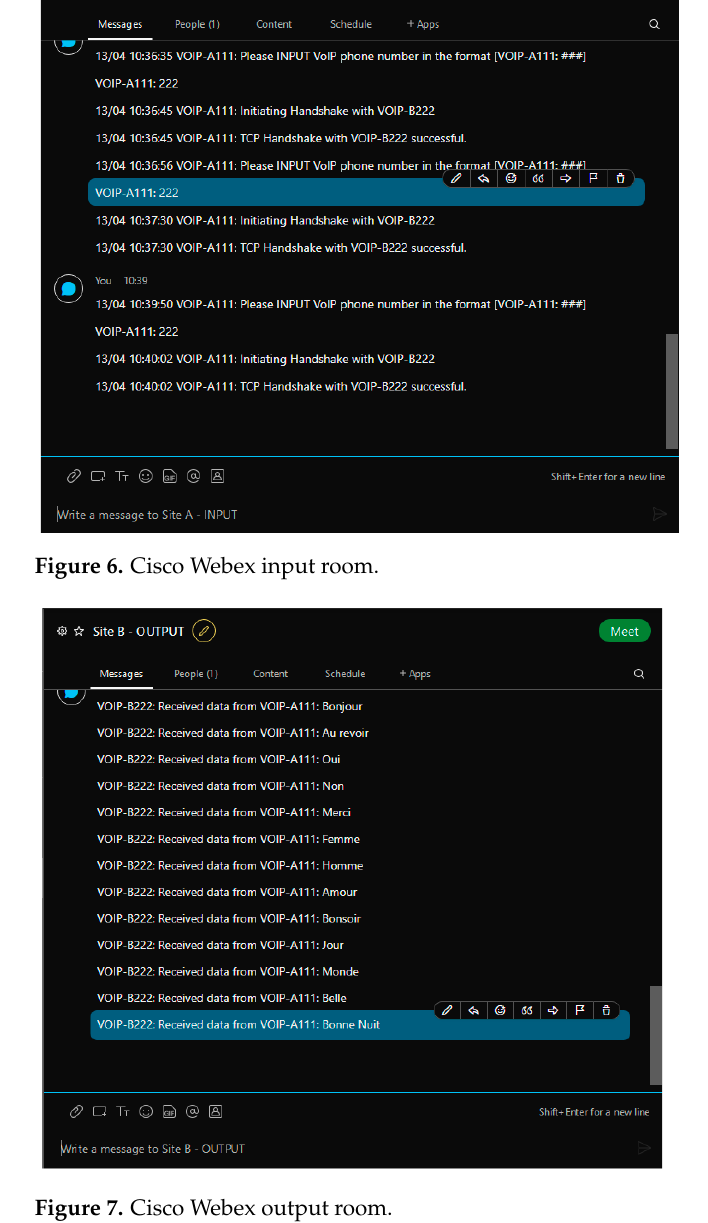
Figure 8. Cisco Webex data collection room. The VoIP phones are composed of a Python code file, executed within CPT using the ‘Thing’ component. The main function of the phones is to initiate a connection from a Site A phone to a Site B phone to transmit voice data. For the purpose of this experiment, the voice data being used is a list of thirteen French words, which, upon being received by a Site B phone, are translated into English and transmitted back to Site A. The phones are controlled through Cisco Webex using a command in the following formats: ‘VOIP-AXX: YY’ for UDP phones, and ‘VOIP-AXXX: YYY’ for TCP phones. Additionally, during each stage of communication, the VoIP phones record the timestamps of communication in the Webex ‘Data Collection’ room. When a connection is first initiated using a Webex command, the first step is to perform a TCP handshake on port 5060, simulating a SIP handshake [20]. This handshake is carried out to ensure the destination phone is receptive and trigger the transmission of voice data by changing the ‘state’ of the phone to ‘1 ′ . Following a handshake, the date and time of the corresponding Webex messages are recorded to the Webex ‘Data Collection’ room as part of the timeline of events. Once the handshake is complete, the simulated voice traffic is sent from the broadcasting phone to the receiving phone. The traditional VoIP phones use UDP port 2000 to transmit the data, using ROUTER-A1 as the gateway, while the modified phones use TCP port 2001 and ROUTER-A2 as the gateway. Using a separate port and router for the set of TCP phones allows them to be dynamically switched to if the network is